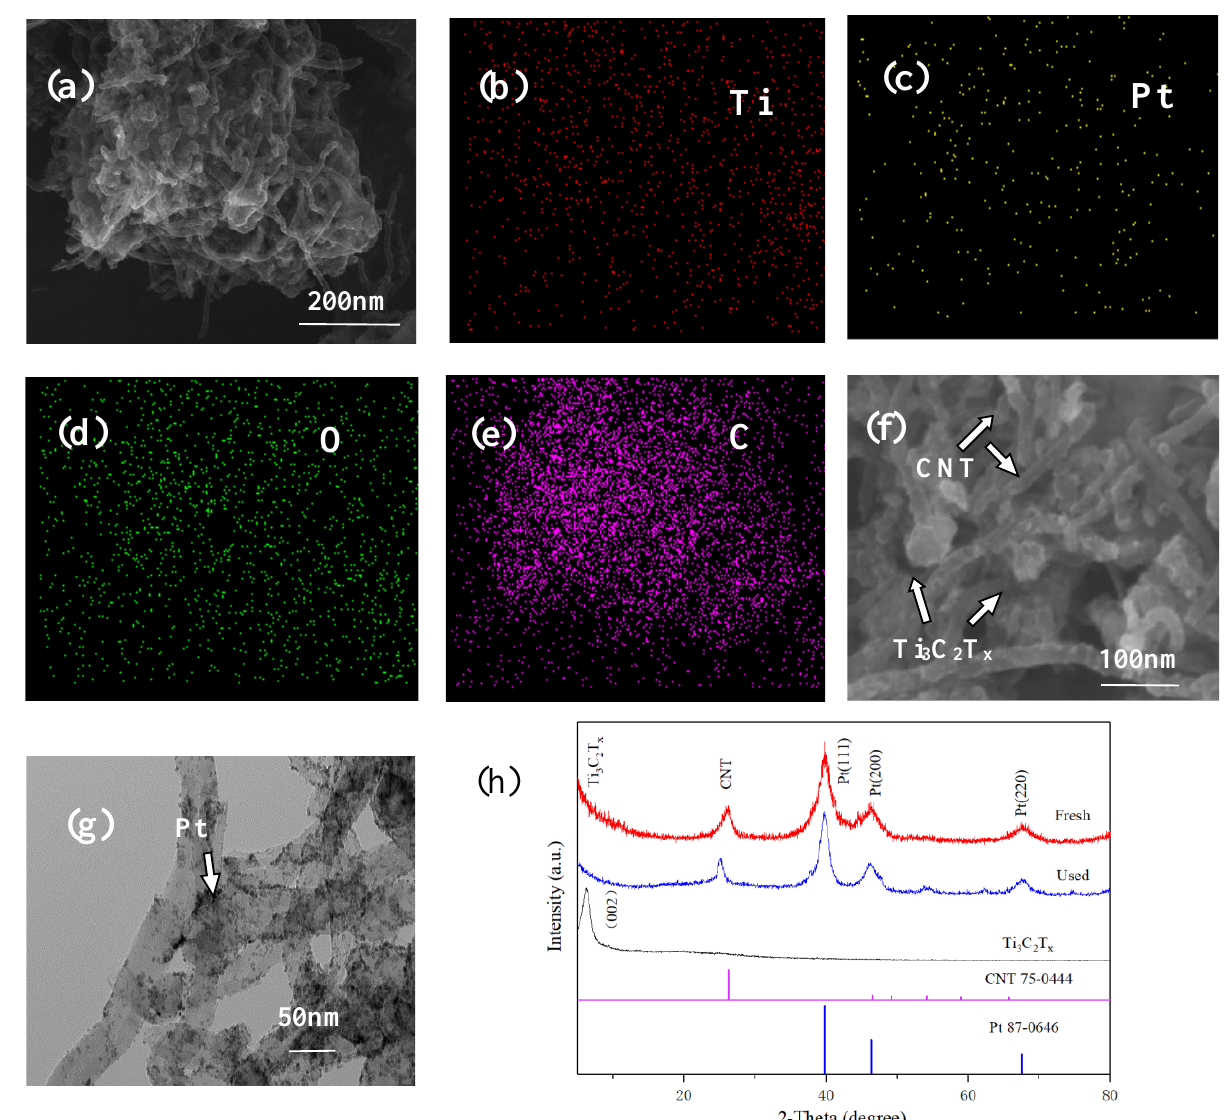
Figure 2. ( a – e ) SEM images and EDS mapping of Pt/Ti 3 C 2 T x -CNT; ( f , g ) SEM and TEM images of Pt/Ti 3 C 2 T x -CNT; ( h ) XRD pattern of Pt/Ti 3 C 2 T x Table 1. Content of elements in Pt/Ti 3 C 2 T x -CNT.